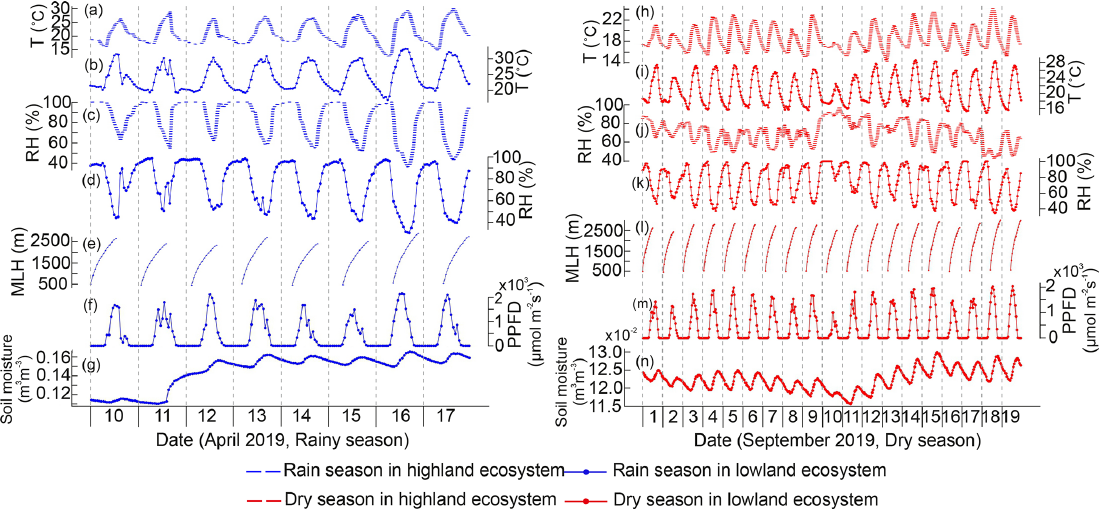
Figure A5. Meteorological measurements in the highland and lowland ecosystems during the rainy and dry seasons. (a, h) Air temperature ( T ) in the highlands, (b, i) T in the lowlands, (c, j) relative humidity (RH) in the highlands, (d, k) RH in the lowlands, (e, l) mixing layer height (MLH) in the lowlands, (f, m) photosynthetic photon flux density (PPFD) in the lowlands, and (g, n) soil moisture in the lowlands.